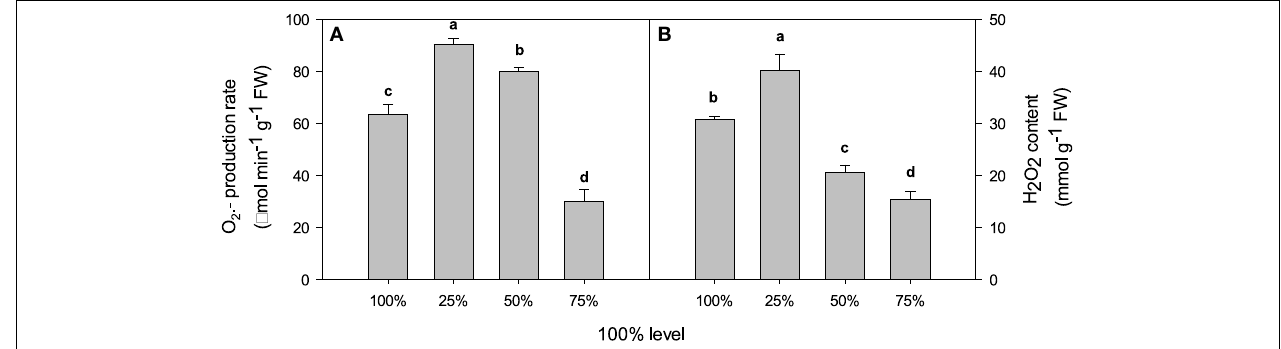
FIGURE 4 | Light intensity and the (A) O . − 2 production rate and (B) and H 2 O 2 content in C. acuminata leaves. The values presented are the means ± SE . Different letters indicate significant differences between irradiance treatments ( P < 0 . 05 ); n = 5 . 100% level = 1500 ± 30 µ mol m − 2 s − 1 .